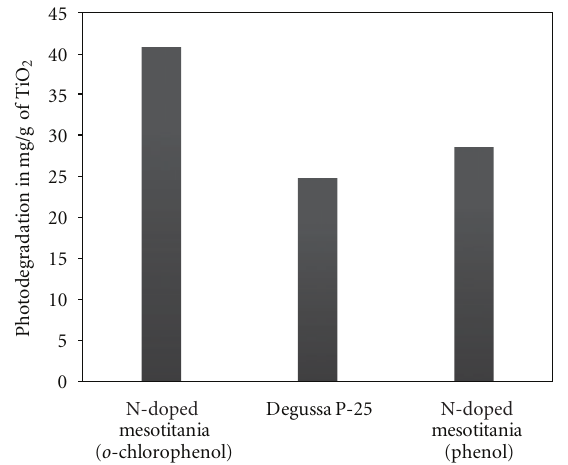
Figure 9: Comparison of N-doped mesoporous titania with Degussa P-25 for photodegradation of o- chlorophenol and phenol.